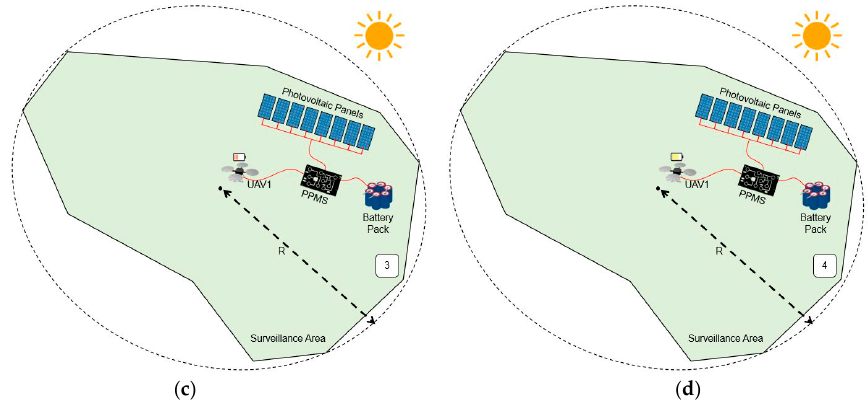
Figure 1. Step by step scenario of the aerial surveillance operation: ( a ) step 1, ( b ) step 2, ( c ) step 3, and ( d ) step 4.